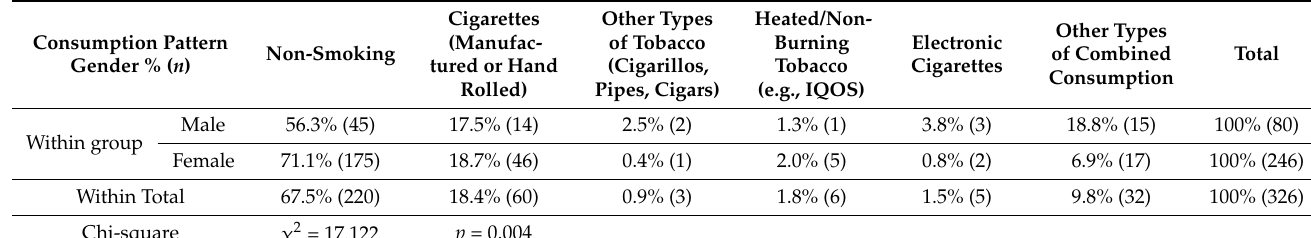
Table 3. Tobacco consumption pattern.